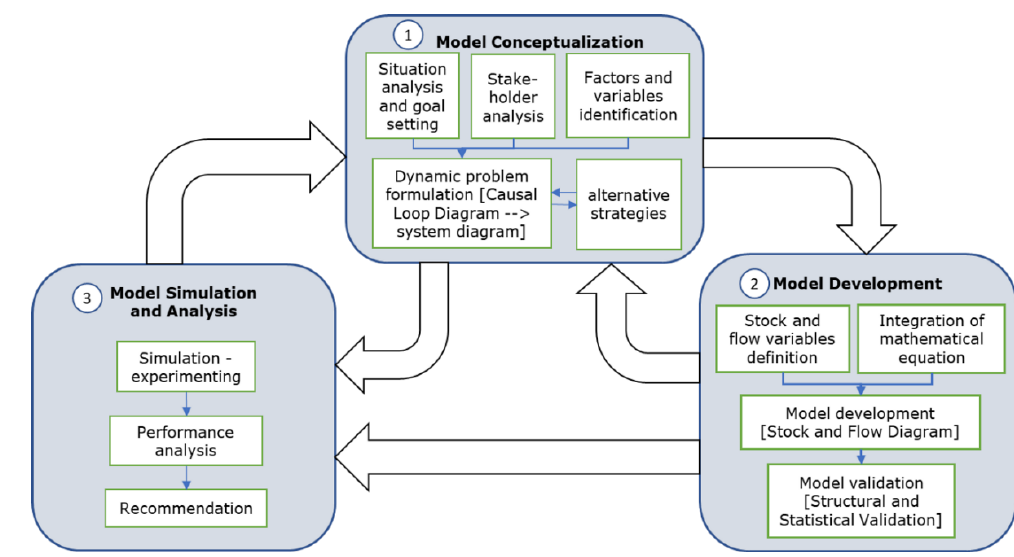
Figure 4. Development of a model-based strategy based on the methodology developed by Sterman [47].